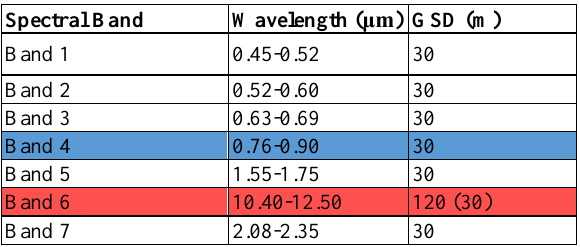
Table 4. Landsat 4-5 TM spectral band characteristics (USGS,